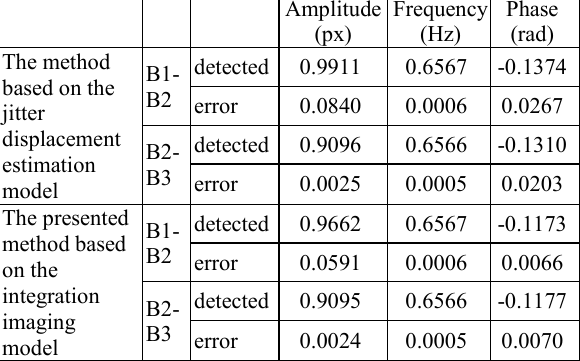
Table 6. Detected results of the jitter